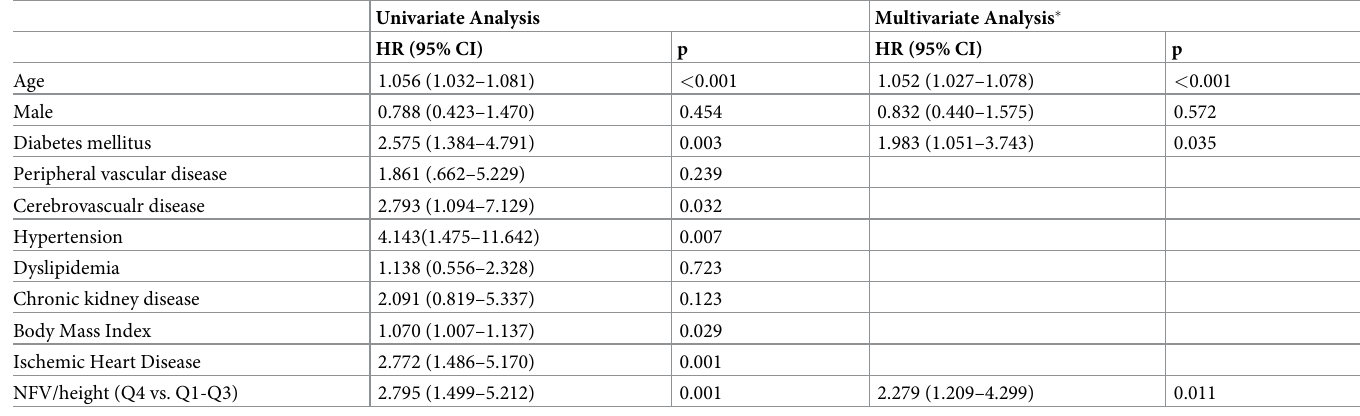
Table 3. Cox proportional hazard regression model with uni and multivariate analysis for co-variates associated with all-cause